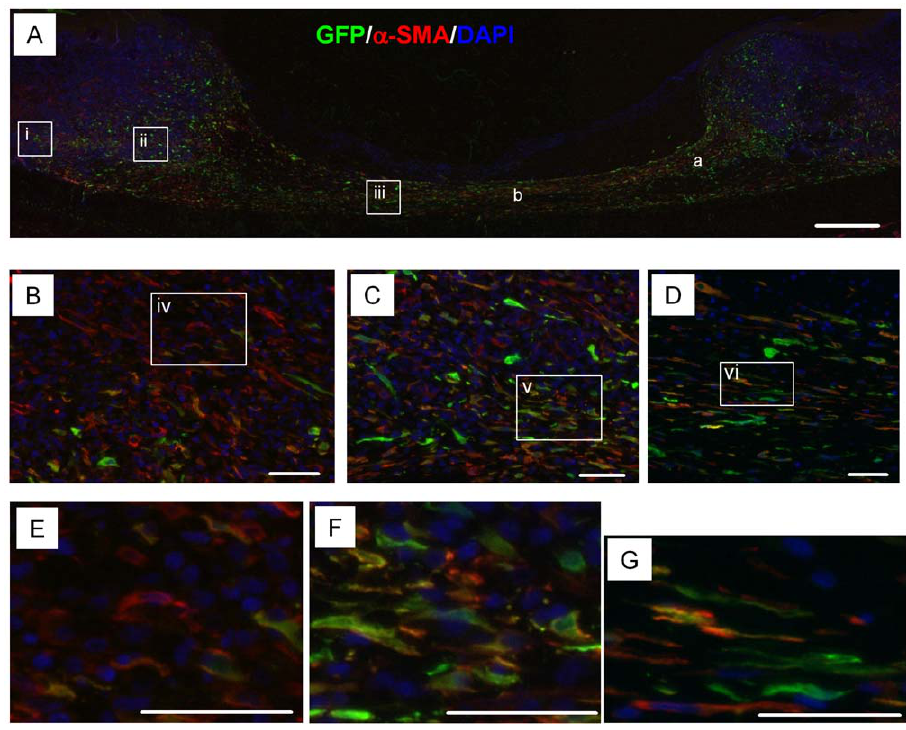
Figure 4. Transplanted ASCs express a -SMA in wounds. GFP-expressing ASCs were analyzed 7 days after transplantation in wounds. Chicken anti-GFP and mouse anti- a -SMA antibodies were used to detect GFP and a -SMA. Nuclei were stained with DAPI. (A): Low magnification of wounds. The areas analyzed in Figure 6 were indicated by ‘a’ and ‘b’. (B–D): Higher magnifications of the indicated regions in A (white squares; labeled as i, ii, iii). (E–G): Higher magnifications of the indicated regions in B–D (white squares; labeled as iv, v, vi). Merged images of a -SMA (red) and GFP (green)